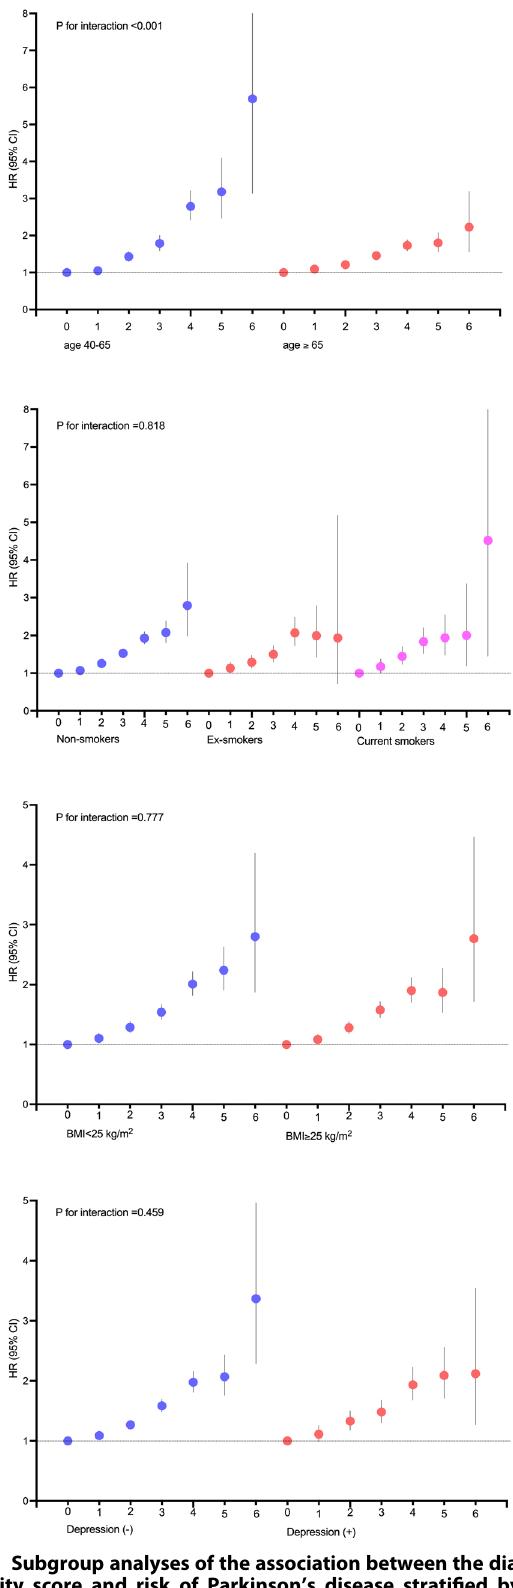
Fig. 2 Subgroup analyses of the association between the diabetes severity score and risk of Parkinson ’ s disease strati fi ed by age, smoking status, obesity, and the presence of depression. Hazard ratios and 95% con fi dence intervals of Parkinson ’ s disease by the diabetes severity score. Adjusted for age, sex, body mass index, alcohol intake, smoking, regular exercise, hypertension, dyslipidemia, and